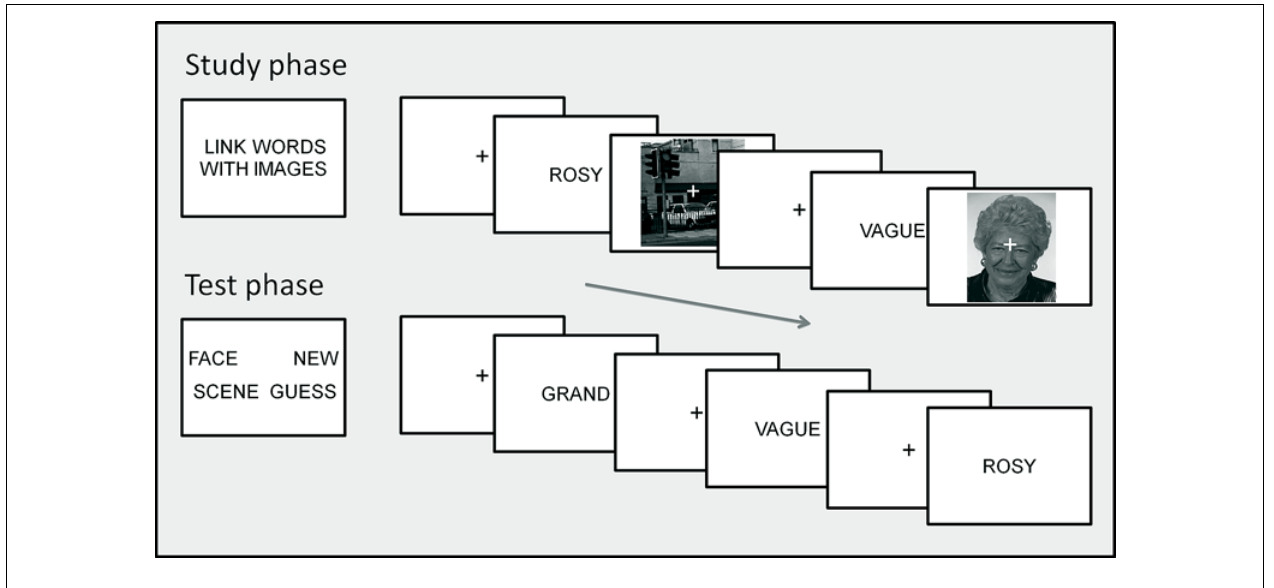
FIGURE 1 |Task procedure. The top section illustrates the study phase instructions (left) and two example trials (right) presenting words with scene and face context. The lower section illustrates the test phase instructions (left) and three example trials presenting